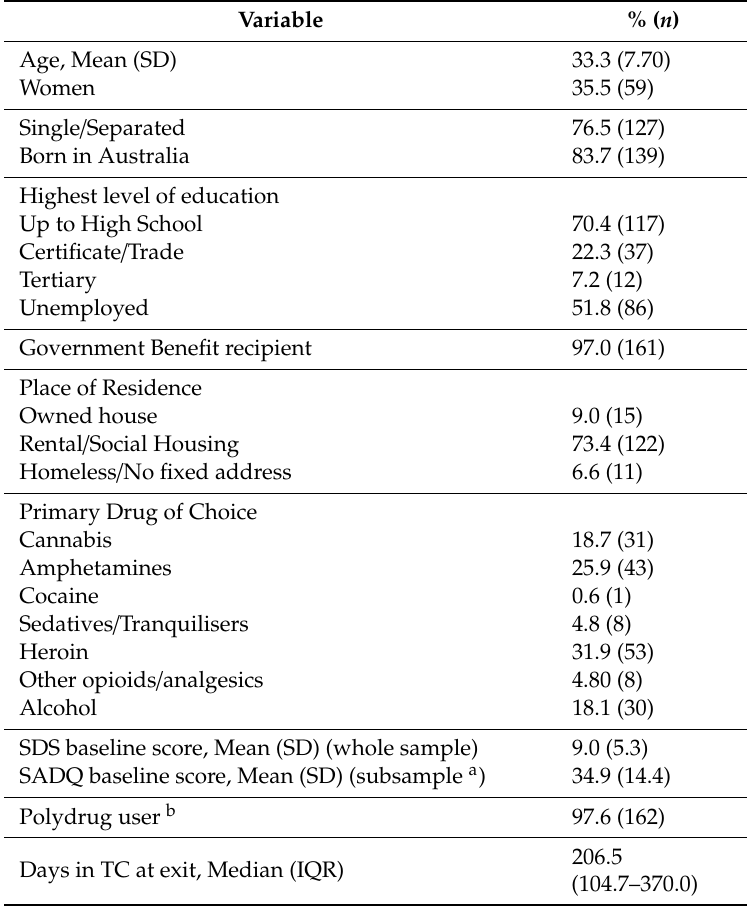
Table 1. Baseline demographics and primary substance use ( n =